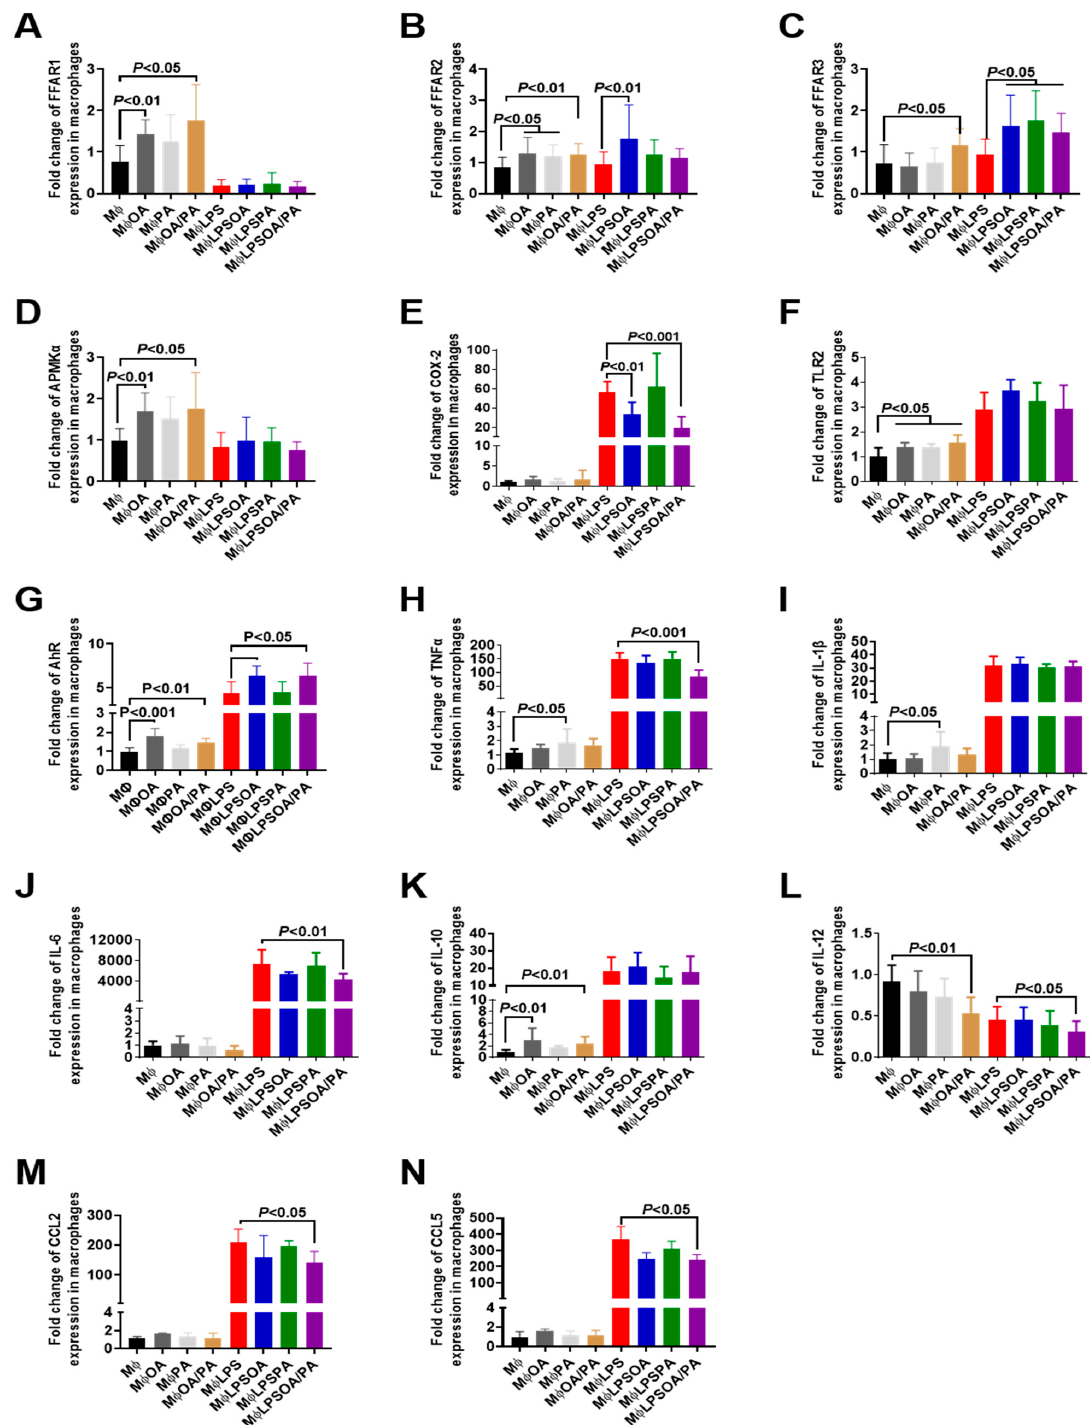
Figure 4. Expression of proinflammatory mediators and receptors in macrophages treated with fatty acids and challenged with lipopolysaccharide (LPS). ( A – N ) Relative expression levels of FFAR1, FFAR2, FFAR3, AMPK α , COX-2, TLR2, AhR, TNF α , IL-1 β , IL-6, IL-10, IL-12, CCL2, and CCL5 mRNA, respectively, in macrophages. M Φ : control group (macrophages alone); M Φ OA, M Φ PA, and M Φ OA/PA: macrophages treated with OA, PA, or FAs (OA/PA), respectively; M Φ LPS: positive control (macrophages exposed to LPS); M Φ LPSOA, M Φ LPSPA, and M Φ LPSOA/PA: macrophages challenged with LPS and treated with OA, PA, or FAs (OA/PA), respectively. The results were obtained from three independent